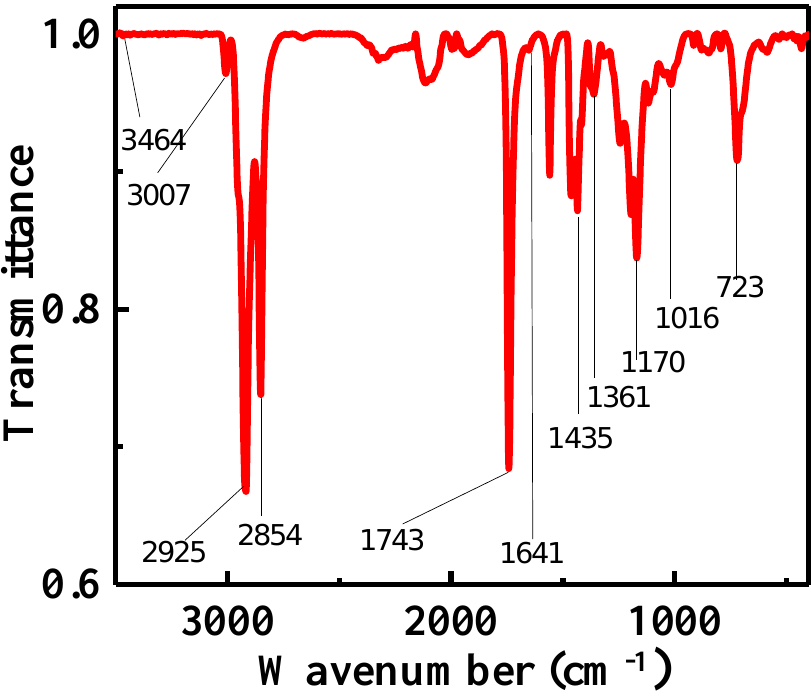
Figure 10. FTIR spectrum of RTME (FAMEs) functional groups.